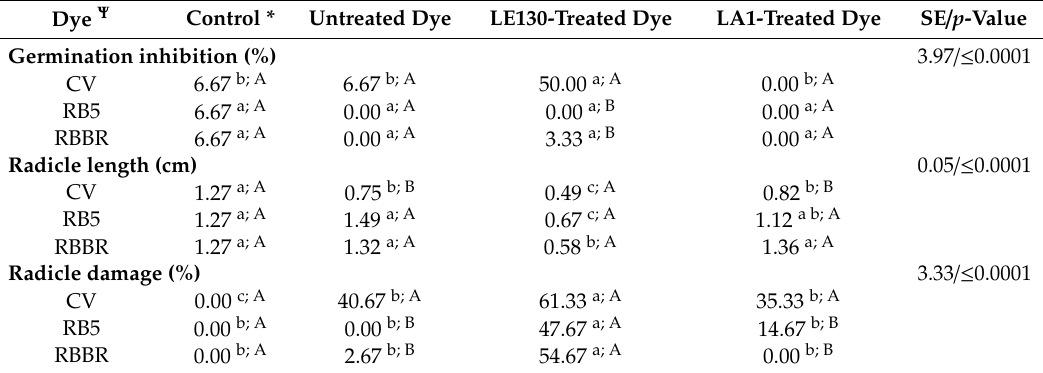
Table 5. Phytotoxicity of the dyes on P. sativum seeds before and after 24 h treatment with T. maxima LE130 and Trametes sp. LA1